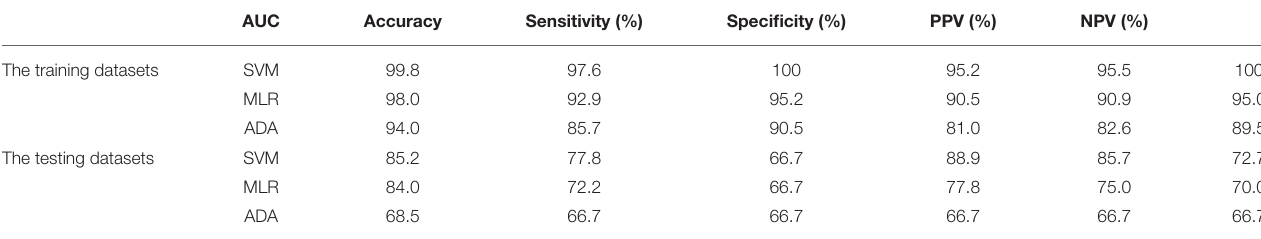
TABLE 1 | Performance of machine learning models for training datasets and testing datasets.